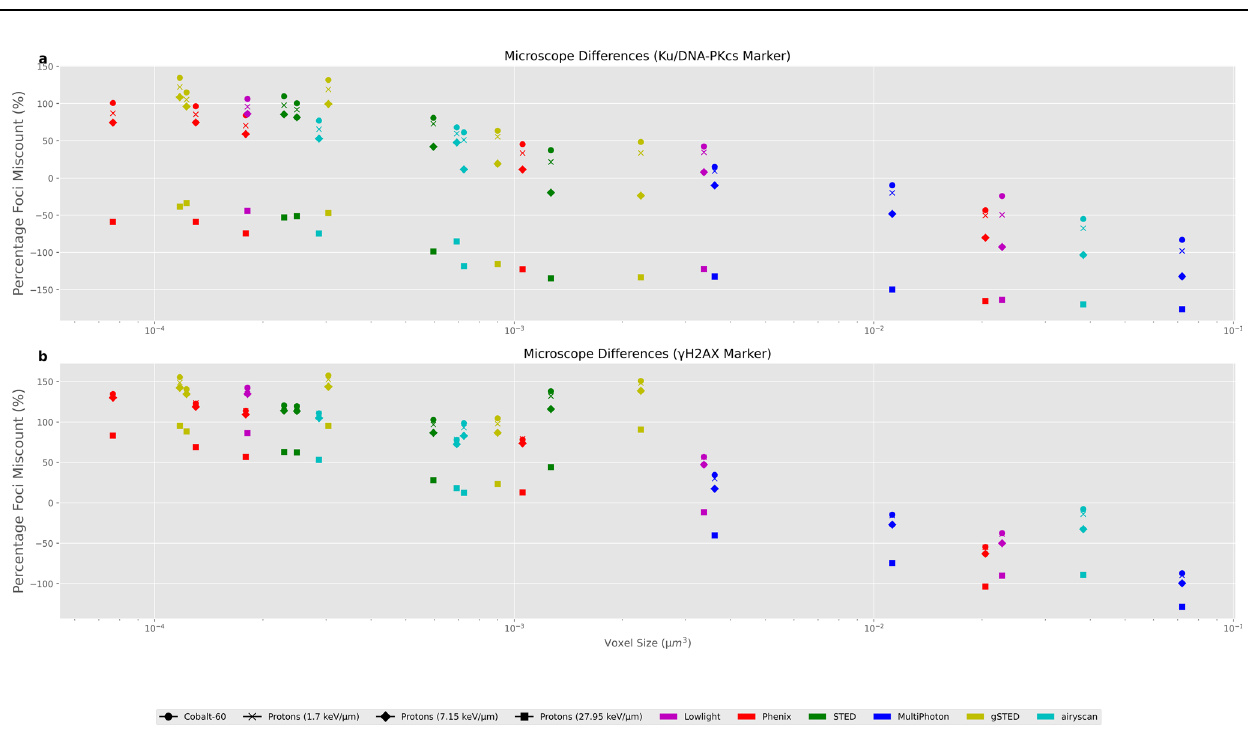
Fig. 5 Comparison of percentage miscounting across all available microscope and magni fi cations. Voxel size has been used as the descriptor of each microscope and is presented on a log axis. a are the results when using a Ku/DNA-PKcs marker. b are the results when using an γ -H2AX marker. Error bars are given as the standard error in the mean for the 1200 microscope images per point (200 cells and 6 time points). Error bars correspond to 1.5 times the interquartile range in either direction. All microscope images are at a 2 Gy